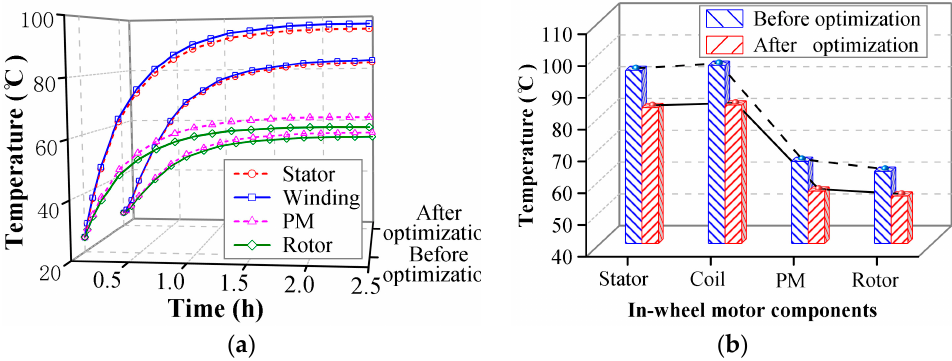
Figure 16. Comparison of temperature changes of PM-IWM components before and after optimization: ( a ) Heating process; ( b ) Peak temperature.